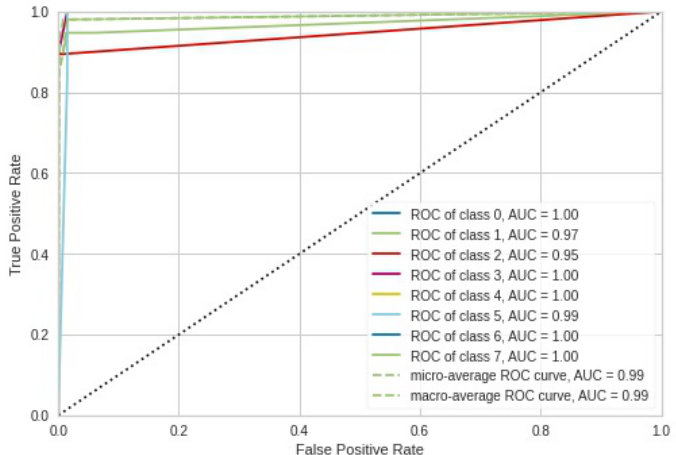
Figure 10. ROC AUC Curves for ontological-bagging-based